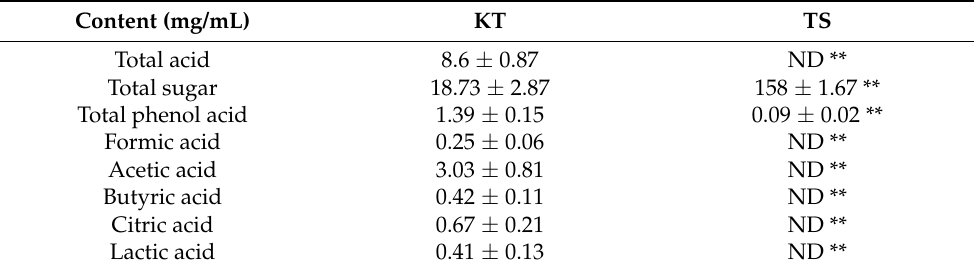
Table 1. The results of product